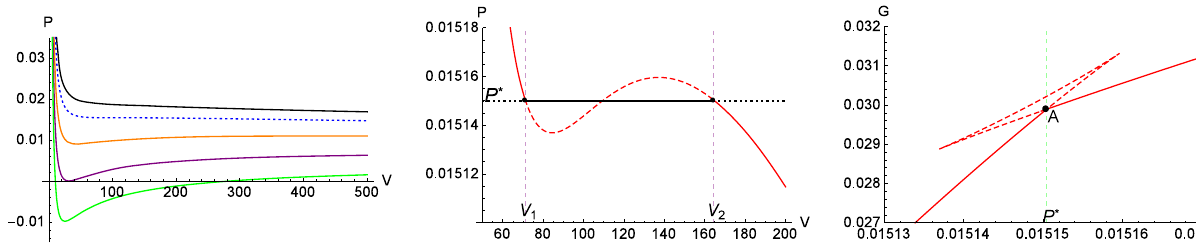
Fig. 1 P − V diagrams described by Eqs. (3.6) and (2.13) and P − G diagram described by Eq. (3.7) at q = − 2. Left The temperature takes the values of T = 0 . 12000 ( black ), T = T c = 0 . 11081 ( blue dotted ), T = 0 . 09500 ( orange ), T = 0 . 07520 ( purple ), and T = 0 . 05500 ( green ), respectively. Middle The temperature takes the